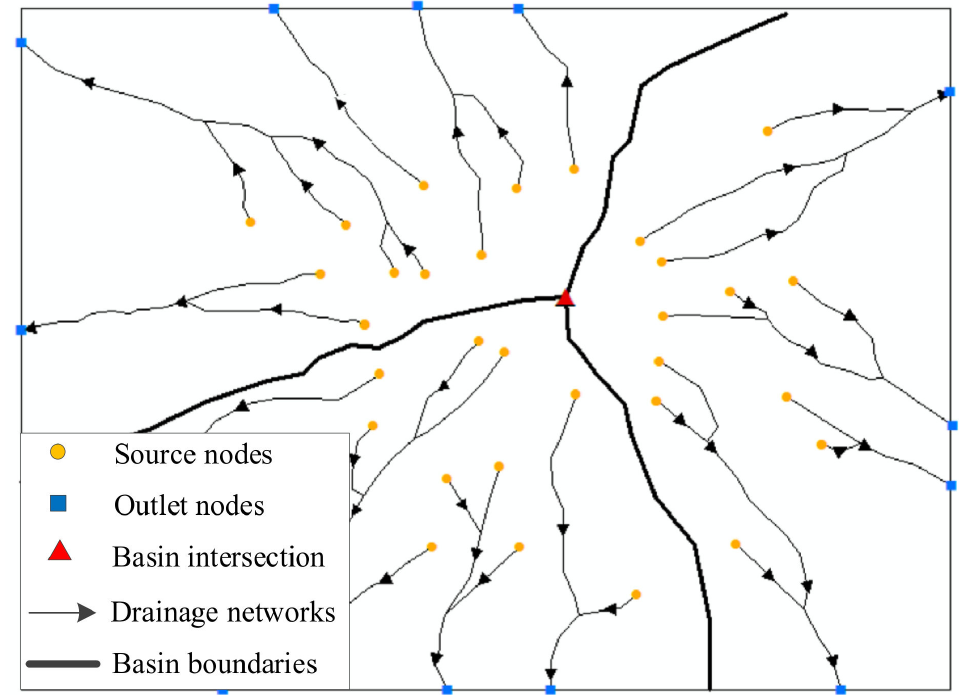
Figure 5. Schematic representation of